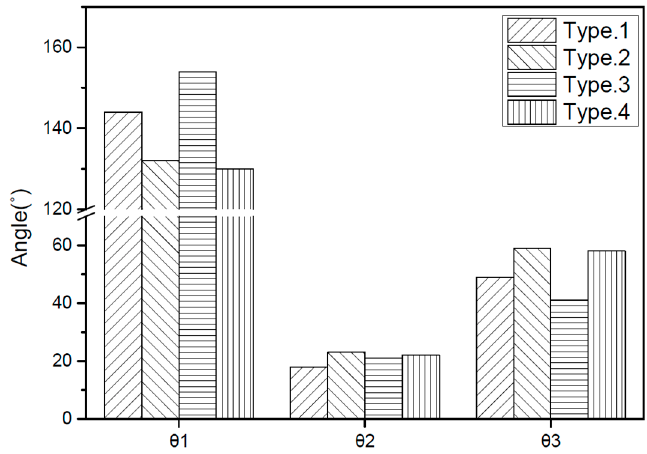
Figure 11. Measured angle of each part on the weld bead.